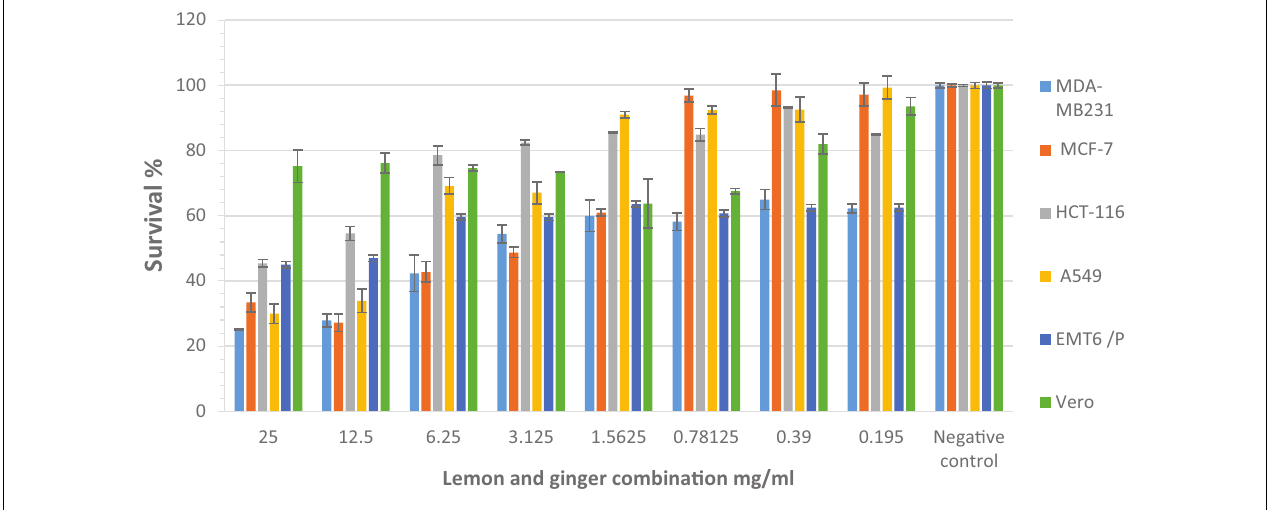
FIGURE 1 | The antiproliferative activity of different concentrations (25–0.195 mg/ml) of the lemon and ginger water extract seen after the treatment of six cells with serial dilutions of water extract. *Significant values when compared with Vero cells proliferation ( P -value = 0.05). TABLE 2 | The IC 50 values (mg/ml) for lemon and ginger extract and vincristine against various cell lines. Analyzed plants MCF-7 MDA-MB231 HCT-116 A549 EMT-6/P Vero-normal cell line cell line cell line cell line cell line cells Lemon and ginger 4 ± 0.600 3.5 ± 0.500 14 ± 1.300 6.5 ± 2.000 11 ± 1.700 > 25 IC 50 (mg/ml) Vincristine (positive control) 0.013 ± 0.008 0.025 ± 0.002 0.021 ± 0.009 0.008 ± 0.001 0.041 ± 0.006 > 0.05 Ten mice were used in each group. mm 3 , cubic millimeter.